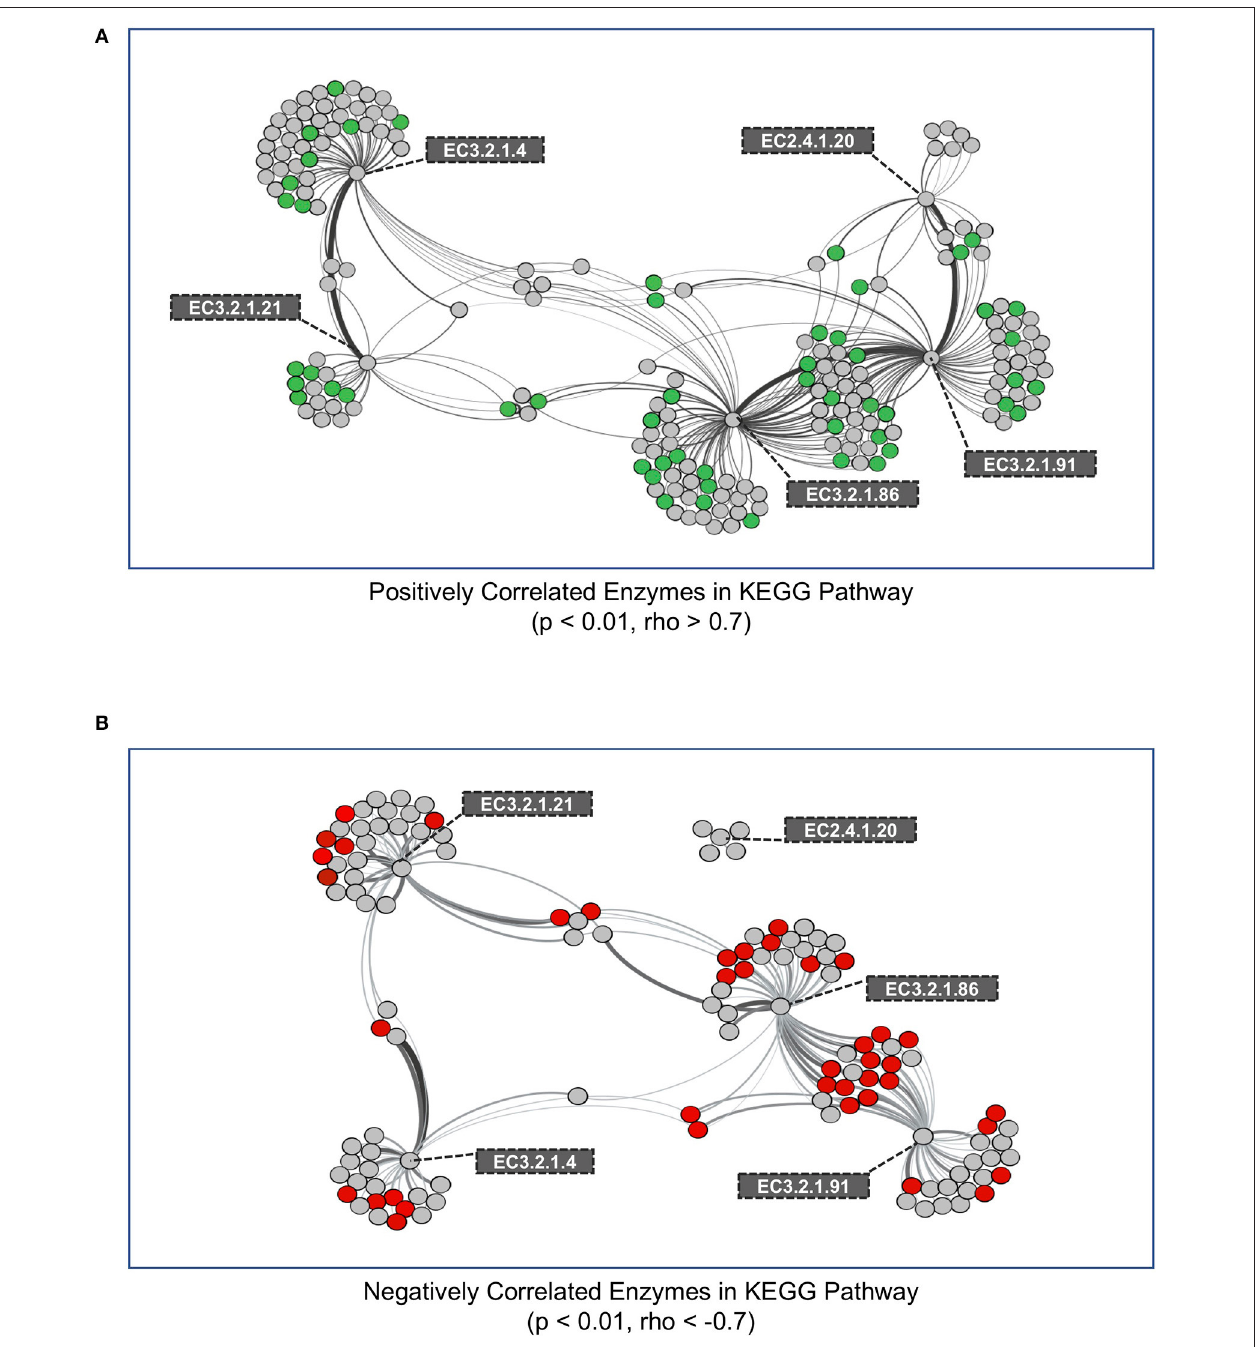
FIGURE 4 | Co-occurrence network of KEGG enzymes with significant interactions among cellulose decomposition enzymes. (A) Positively correlated KEGG enzymes with an enzyme in the cellulose decomposition pathway. Green nodes represent KEGG enzymes that are enriched in medium aggregates compared to whole soil. (B) Negatively correlated KEGG enzymes with an enzyme in the cellulose decomposition pathway. Red nodes represent KEGG enzymes that are observed in lower abundances in medium aggregate compared to whole soil. Thickness of edges represent the strength of correlation between